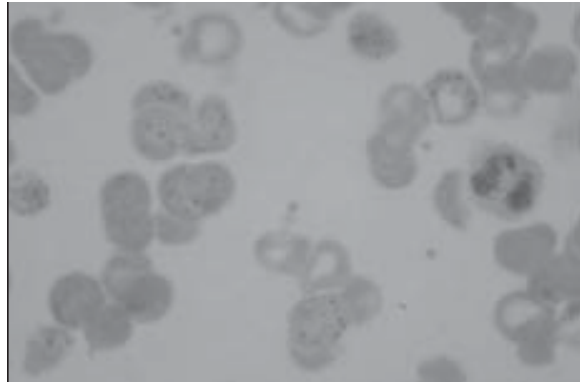
Figure 1 – Blood smear of peripheral blood. Source: